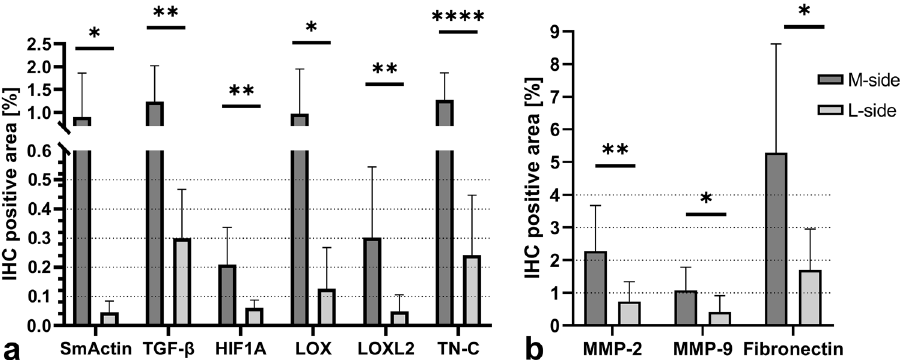
Figure 2. Immunohistochemical antibody detection. The percentage of ( a ) SmActin, TGF-β, HIF1A, LOX, LOXL2 and TN-C positive area and ( b ) the percentage of MMP-2, MMP-9 and Fibronectin positive area after immunohistochemical (IHC) detection . Data are presented as mean ± SD (n = 10). Values connected by lines differ significantly from each other (*p < 0.05, **p < 0.01, ***p < 0.005, ****p < 0.0005).